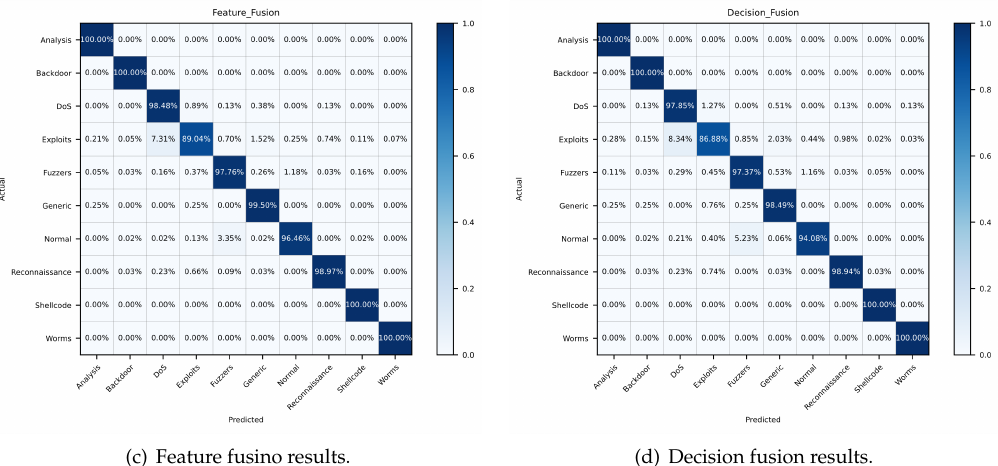
Figure 9. Confusion matrices of detection results on dataset NB15. True labels are on vertical axis and predicted labels are on horizontal axis.